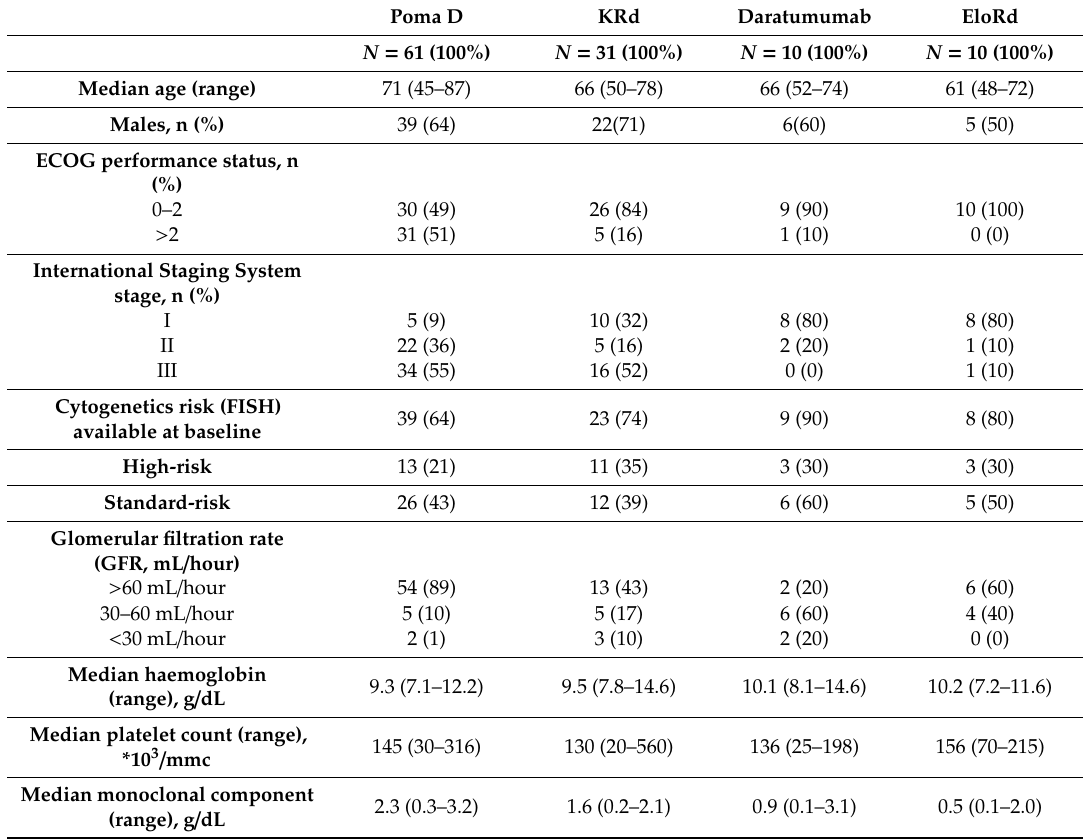
Table 1. Demographic and clinical characteristics of MM patients included in the study. Poma D